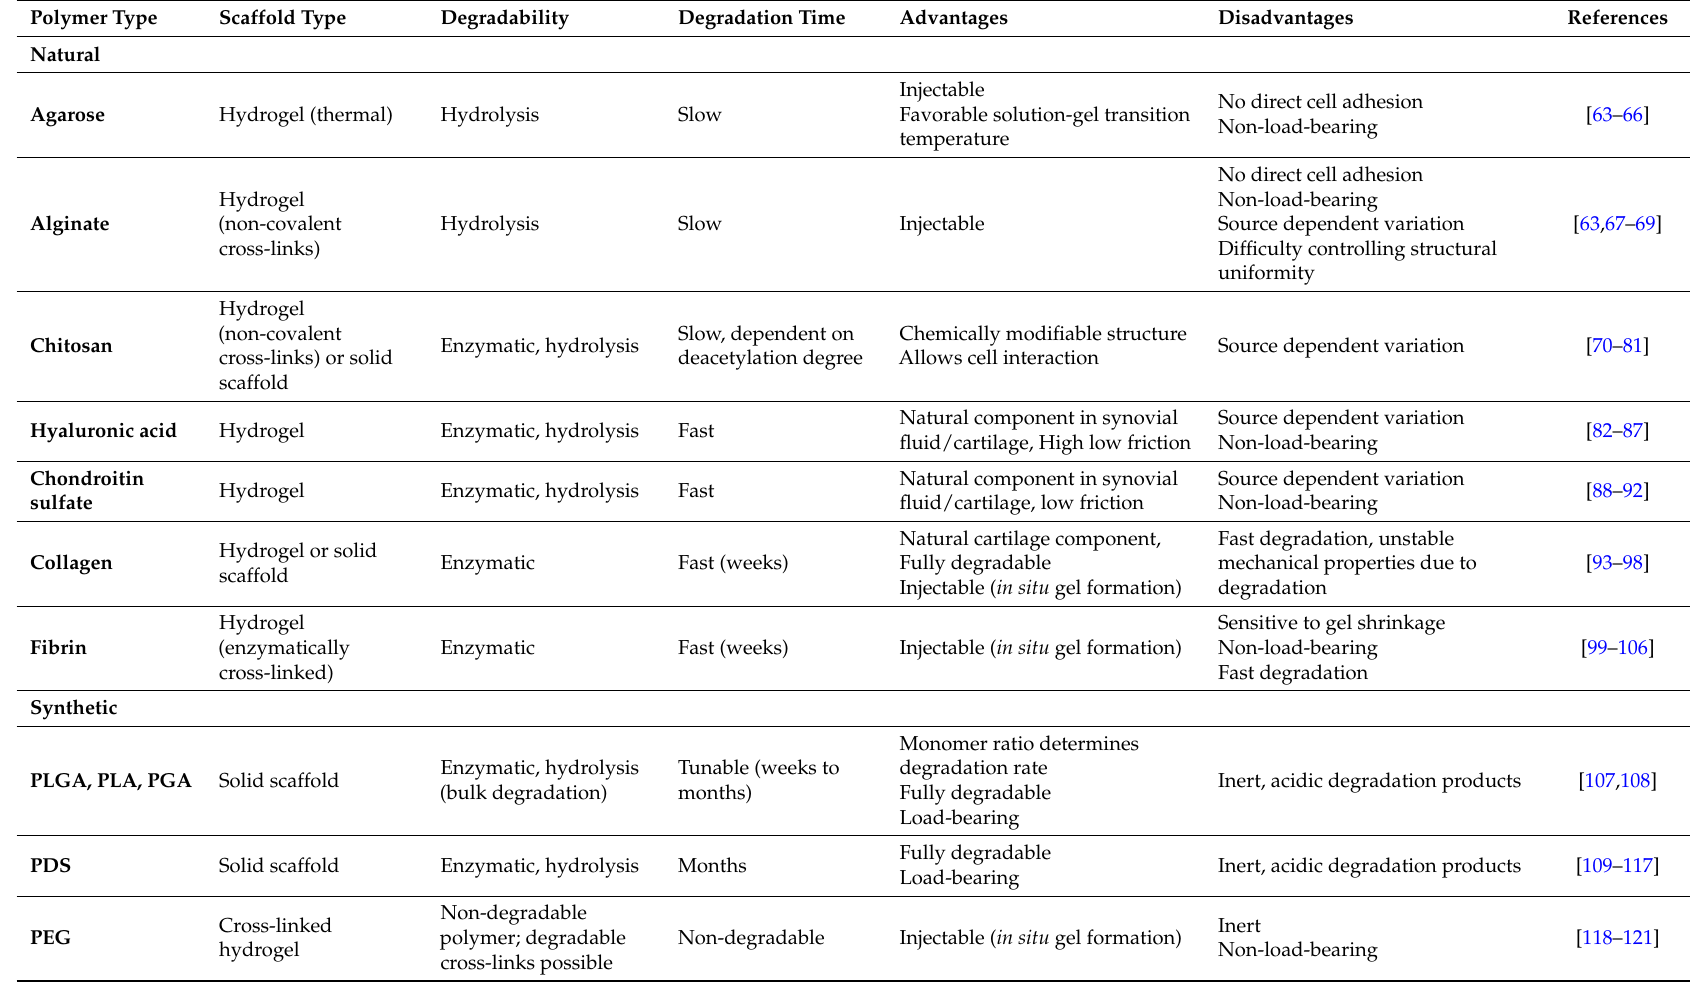
Table 1. Table 1 gives general properties of polymers used in clinical repair of osteochondral